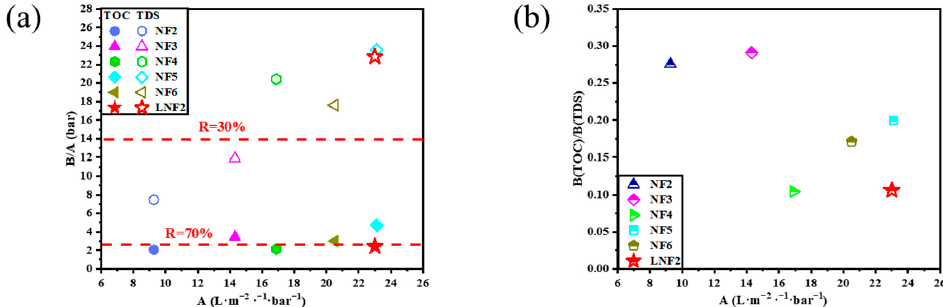
Figure 5. FEEM spectra of the feed water (on the left) and the permeate water (on the right) when LNF2 was used. ( a1 ) An activated carbon filter effluent collected from a local pilot plant and ( a2 ) the permeate; ( b1 ) the synthetic feed water containing fulvic acid and ( b2 ) the permeate; ( c1 ) the effluent of a high-rate settling tank at a surface water treatment plant in Shandong and ( c2 ) the permeate.